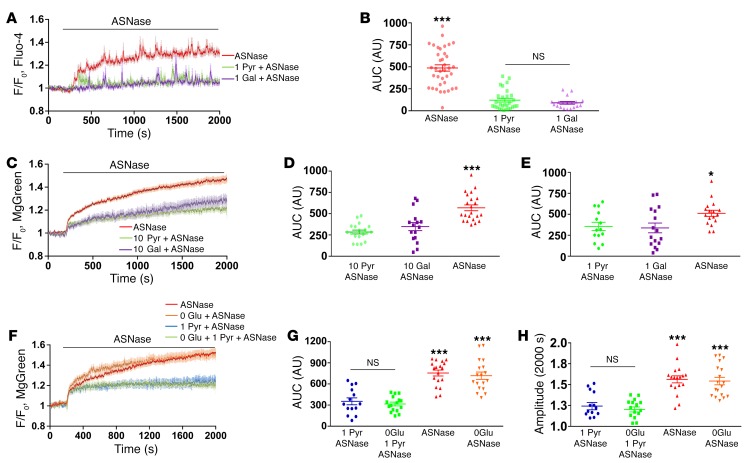
Asparaginase-induced Ca2+ overload and ATP loss were substantially reduced by galactose or pyruvate, but not glucose removal.(A) Asparaginase elicits elevated [Ca2+]i plateau. Averaged traces with error bars shown (red, n = 35). Green trace shows reduced response in the presence of 1 mM pyruvate (after 5 minutes of preincubation, n = 33). Purple trace shows reduced response in the presence of 1 mM galactose (15 minutes of preincubation, n = 17). (B) Comparison of AUC shown in A during first 30 minutes of [Ca2+]i change in the presence of pyruvate (green) and galactose (purple) or asparaginase alone (red) (P < 0.0001). (C) ATP loss was evaluated using MgGreen. Replacement of extracellular glucose (10 mM) with pyruvate (10 mM) (green, n = 19) or galactose (10 mM) (purple, n = 16) for 30 minutes markedly reduces [Mg2+]i change induced by asparaginase (red, n = 38). (D) Quantitative analysis of experiments of type shown in C (AUC during 30 minutes; P < 0.0005). (E) Quantitative analysis of experiments as in C, but with 1 mM of either pyruvate (green, n = 14) or galactose (purple, n = 16). Bars show AUC recorded during 30 minutes of asparaginase application (P < 0.015). (F) Asparaginase induces ATP loss irrespective of glucose presence (red, n = 21) or absence (orange, n = 17). Pyruvate (1 mM) decreased ATP depletion irrespective of glucose absence (green trace, n = 16) or presence (10 mM) (blue trace, n = 14). (G) Quantitative analysis of experiments shown in F by AUC during 30 minutes of asparaginase application. Pyruvate (blue and green) was highly protected against ATP depletion (P < 0.0001) regardless of glucose (P > 0.05). (H) Amplitudes at 2,000 seconds shown in F. Pyruvate (blue and green) is protected against ATP depletion; P < 0.0001 regardless of presence (red) or absence of glucose (orange). *P < 0.05; ***P < 0.001, 1-way ANOVA.